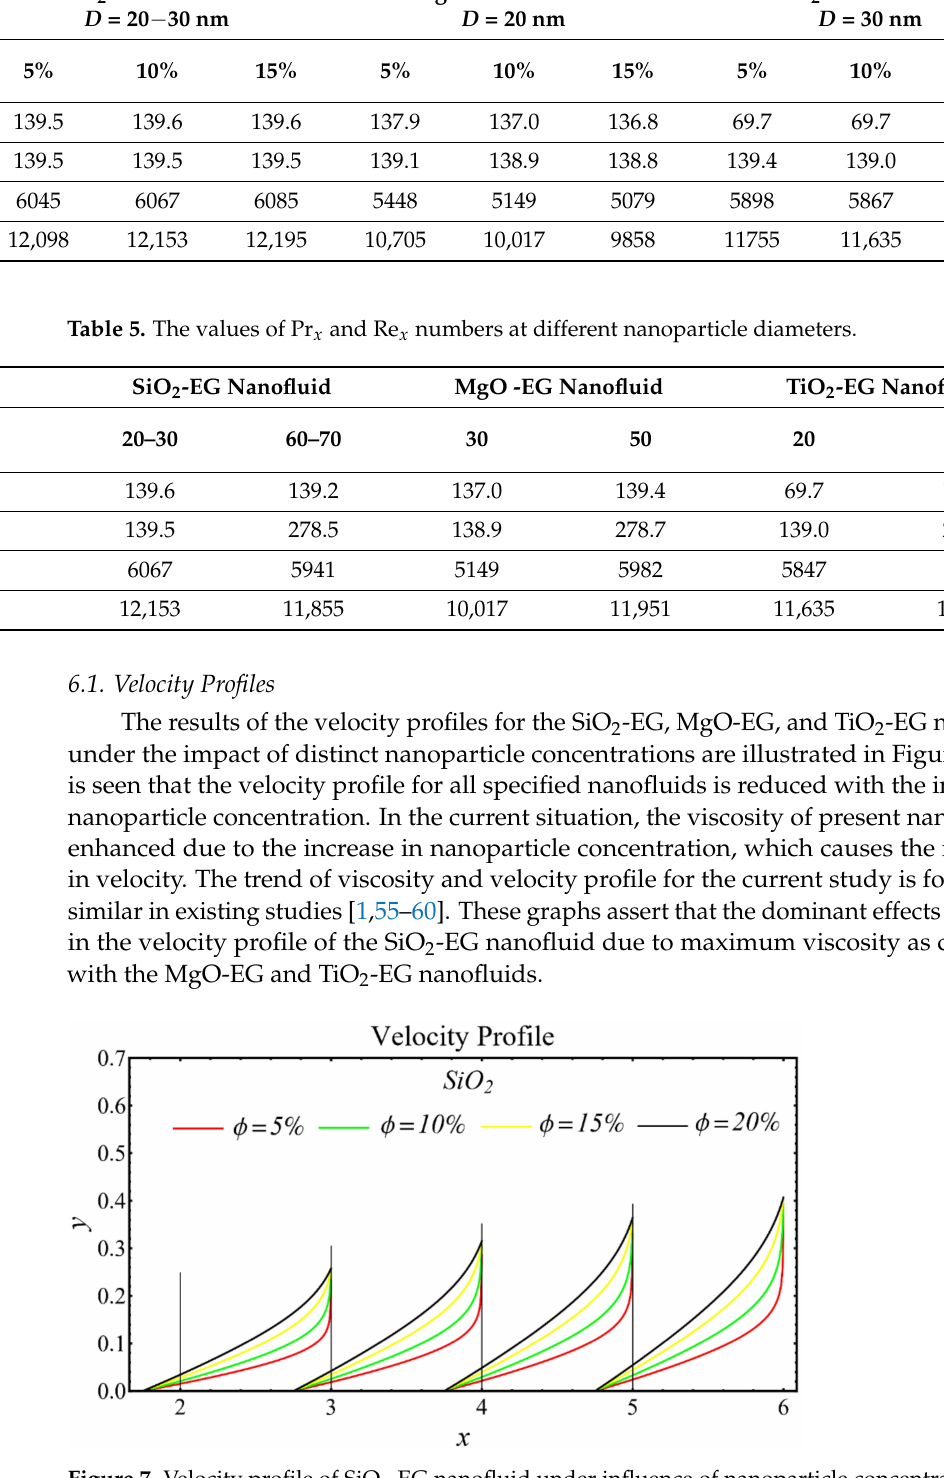
Figure 7. Velocity profile of SiO 2 -EG nanofluid under influence of nanoparticle